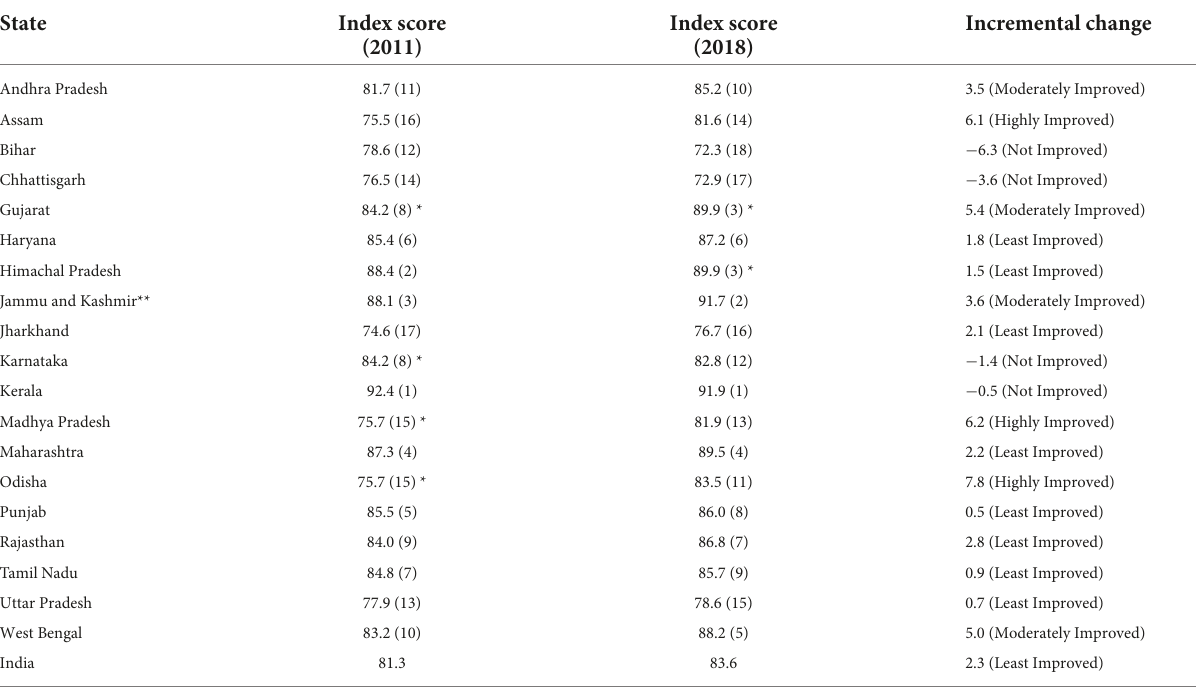
TABLE 4 Composite age-specific mortality index scores for rural Indian women and its incremental changes from the base year to reference year. Composite age-specific mortality